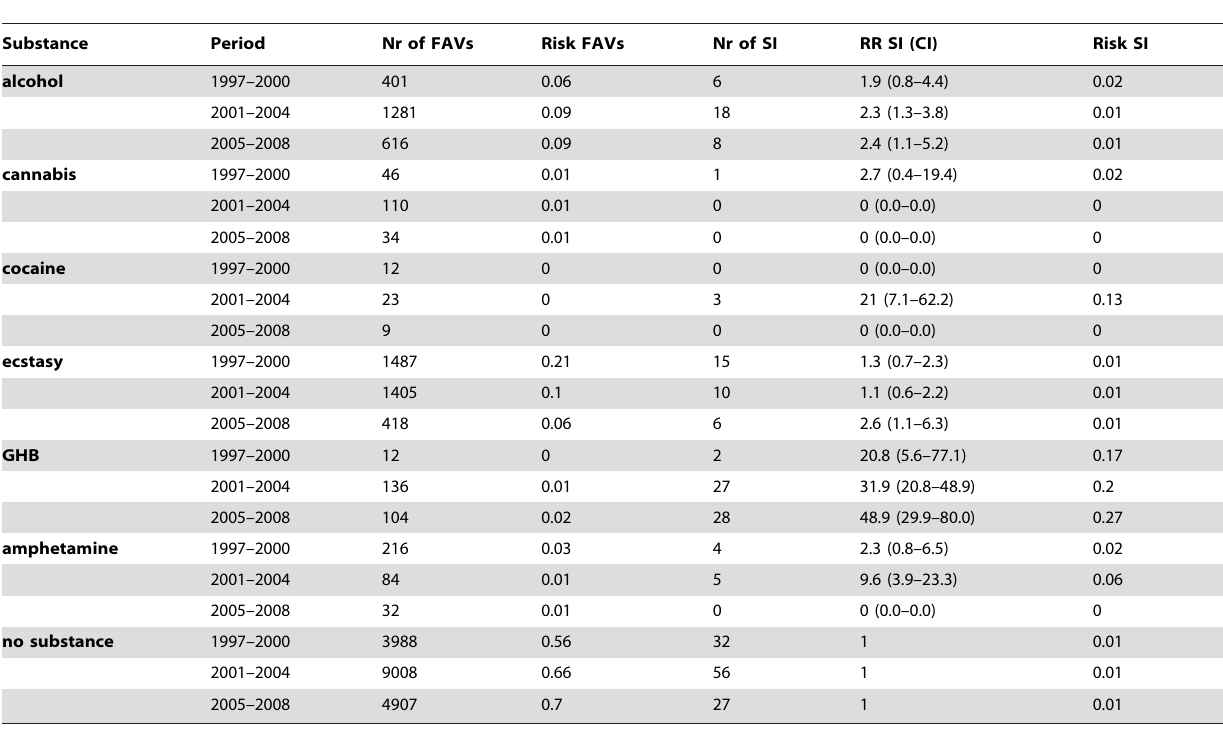
Table 5. Number and risk of first-aid visits and serious incidents associated with using different substances individually.